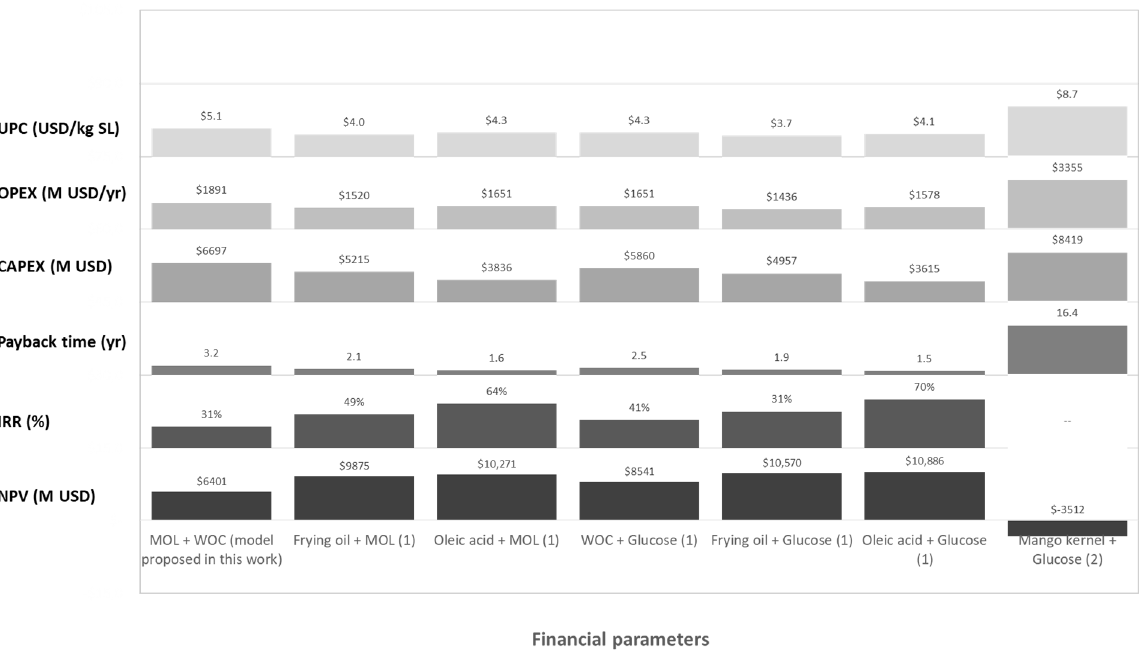
Figure 4. Financial parameters for the SLs production scenarios using different substrates. Nomen- clature: WOC: Winterization oil cake; MOL: sugar molasse. (1) Jim é nez-Peñalver et al., [41] (2); Parekh et al.